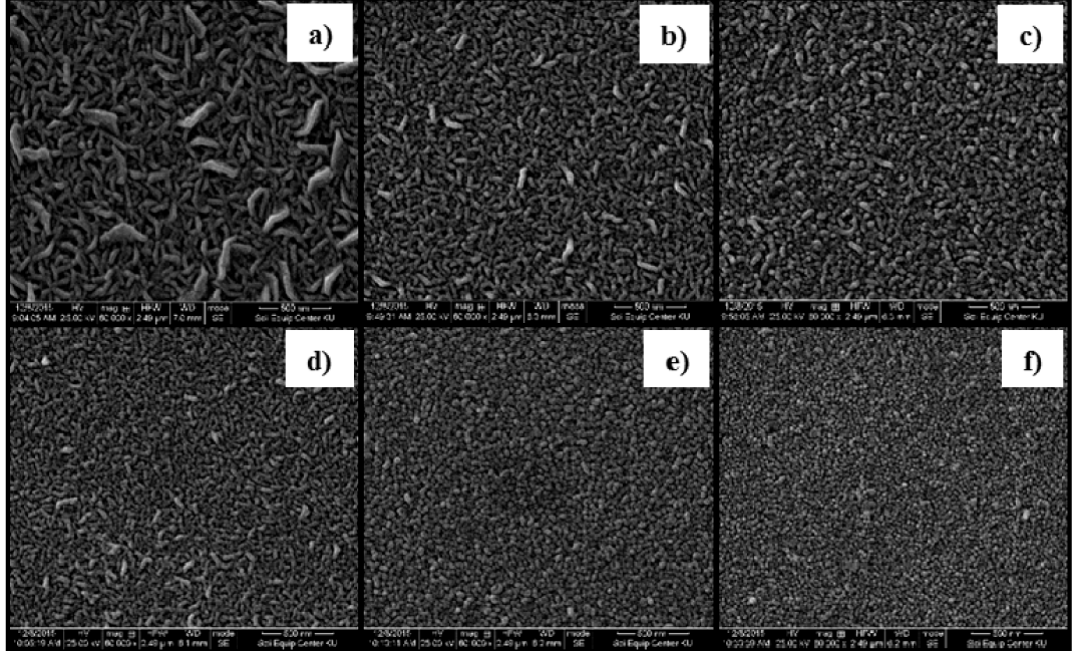
Figure 2. SEM images for AZO films obtained from spray pyrolysis with varying Al-doping contents: ( a ) 0 at.% (undoped), ( b ) 1 at.%, ( c ) 2 at.%, ( d ) 3 at.%, ( e ) 4 at.%, and ( f ) 5 at.%. Reproduced with permission from ref. [51].